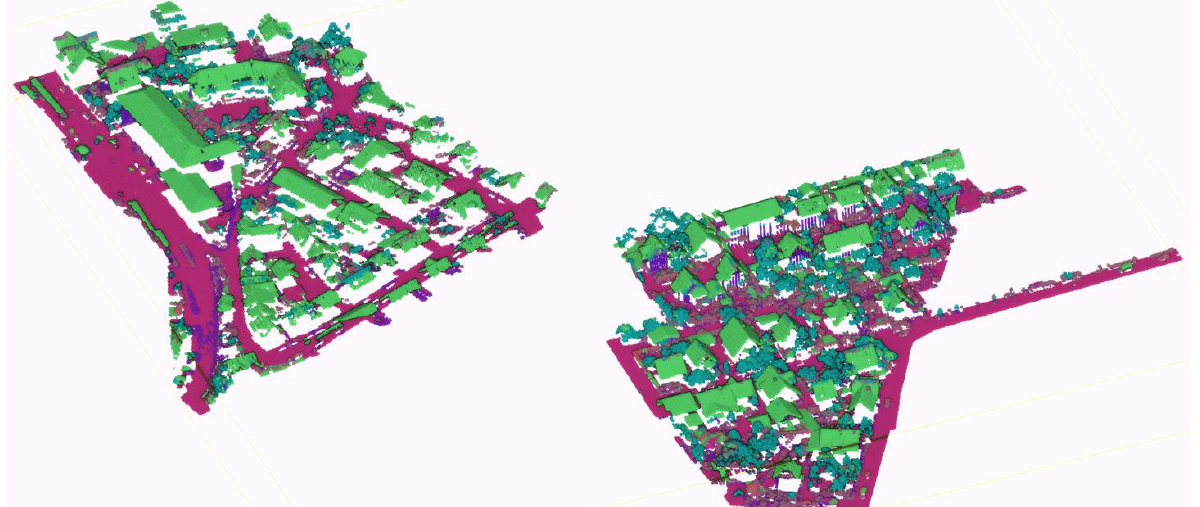
Figure 17. 9-class classification result for Vaihingen evaluation data.